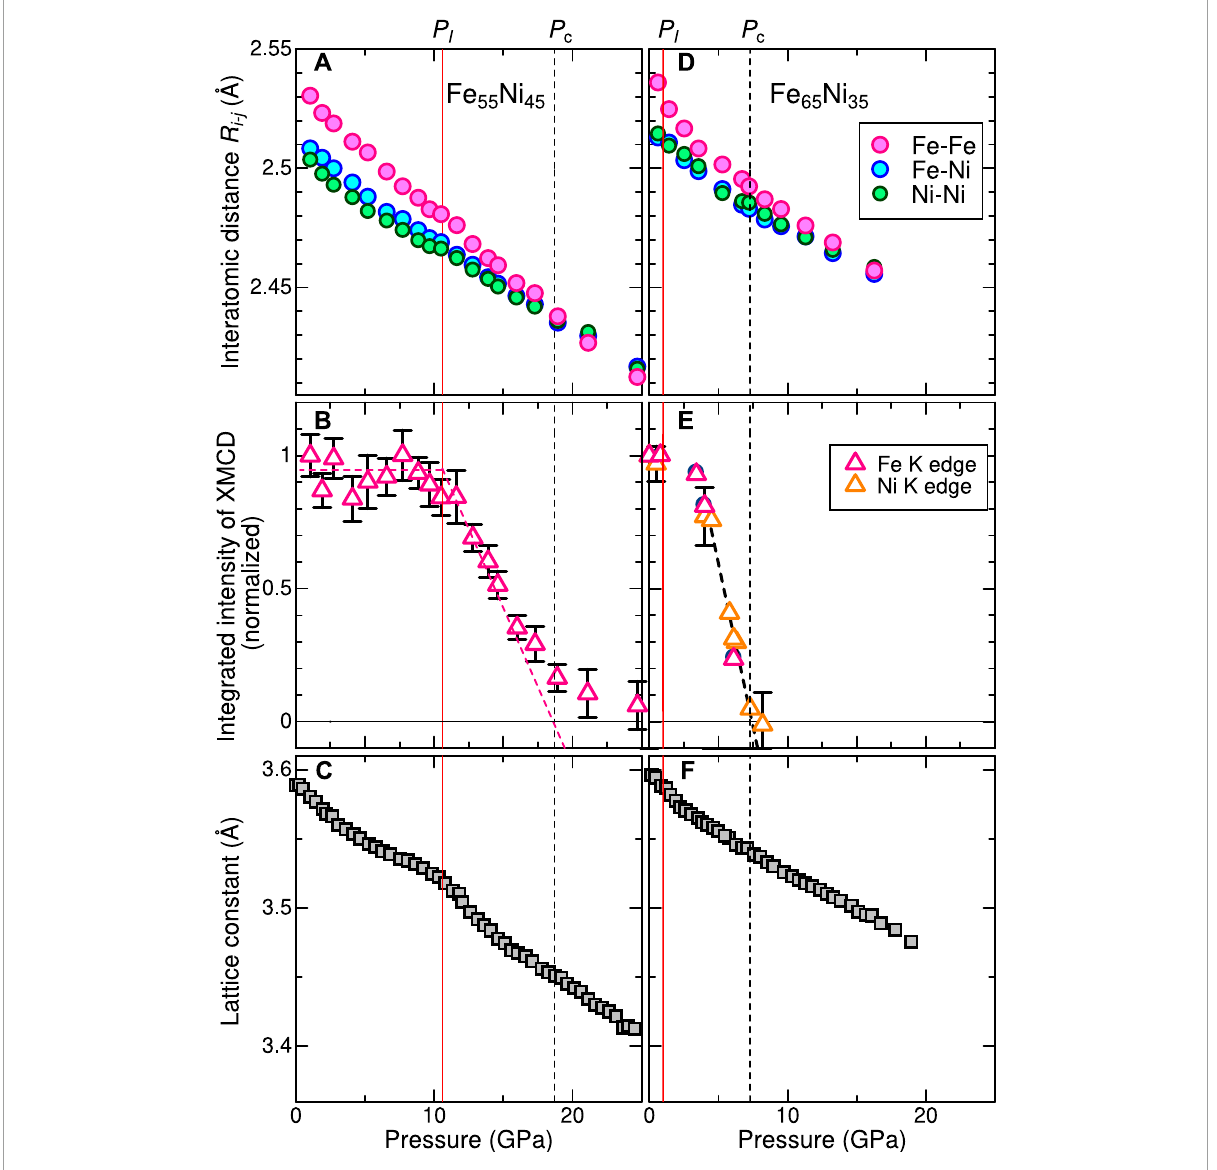
FIGURE 3 Comparison of the results between Fe 55 Ni 45 non-Invar alloy and Fe 65 Ni 35 Invar alloy as a function of pressure: (A, D) Average lengths of R ij fitted within a range of 0.6 Å centered on the 1NN peaks of Fe-Fe, Fe-Ni, and Ni-Ni pairs. (B,E) Integrated intensity of X-ray magnetic circular dichroism (XMCD). (C, F) Compression curves determined by XRD. The vertical solid and dashed lines represent characteristic pressures P I and P c